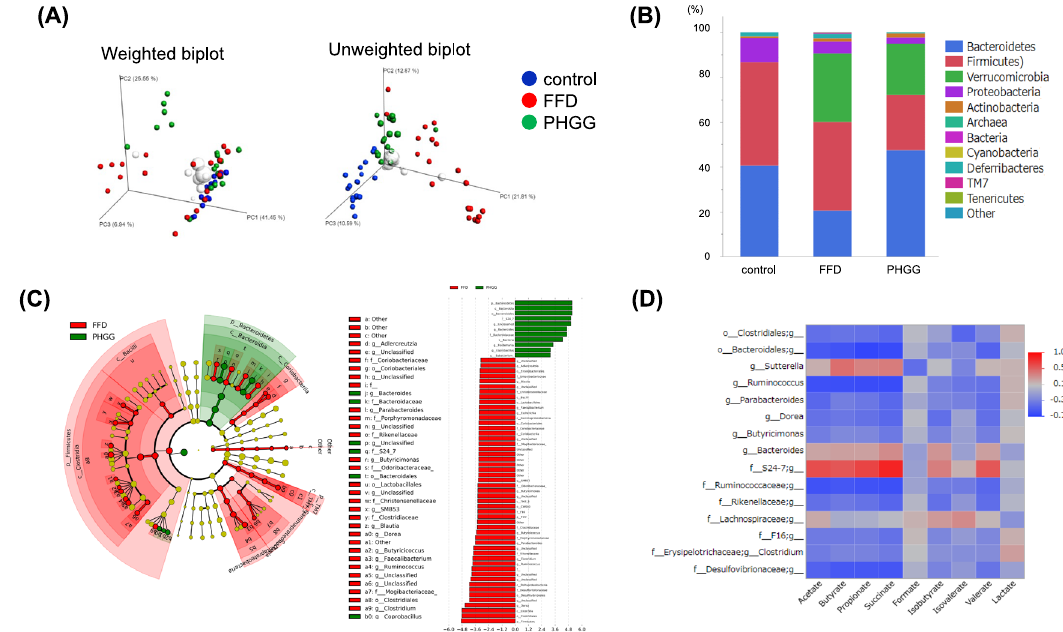
Fig. 3 Data for analysis of intestinal bacteria in fresh mouse stool. A Principal component analysis. B Percentage of gut bacteria at the phylum level. C Genus-level analysis of intestinal bacteria using Lefse. D Heat map on the correlation between intestinal bacteria and short- chain fatty